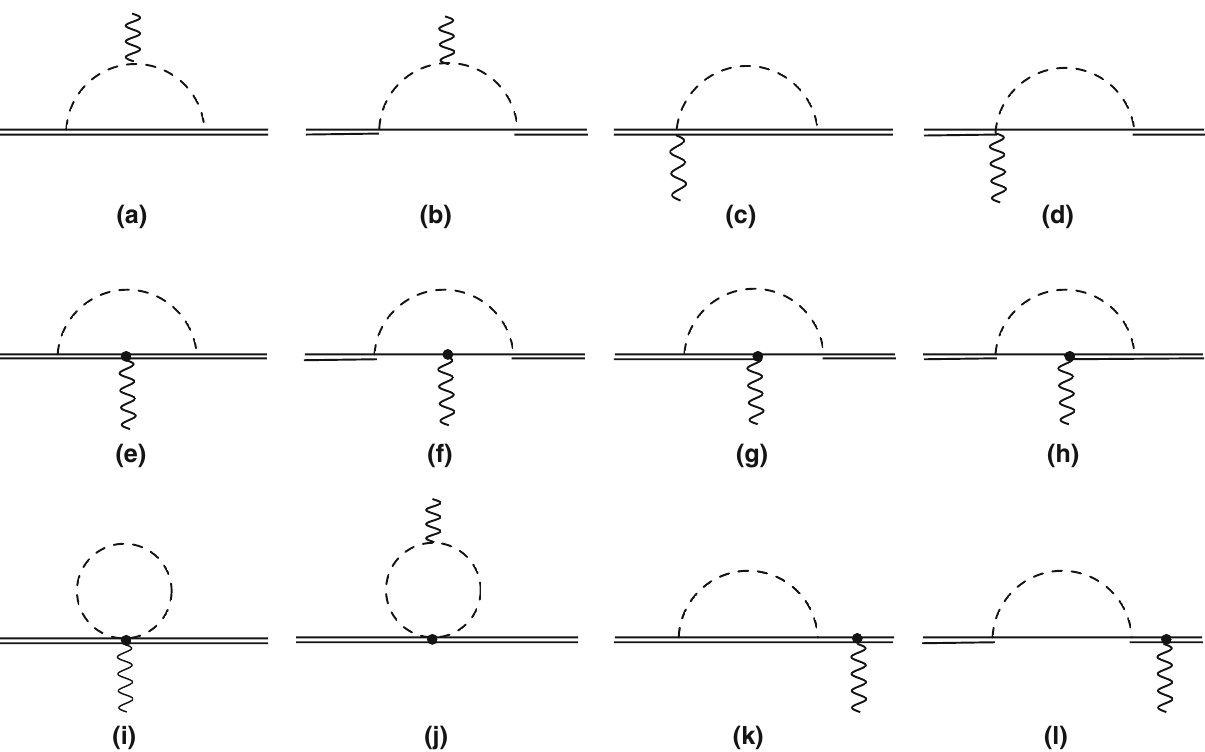
Fig. 2 The one-loop diagrams where the spin- 3 wiggly lines represent the pseudoscalar meson and photon, respectively. The solid dotes represent O ( p 2 ) vertices, while the other vertices are at the leading